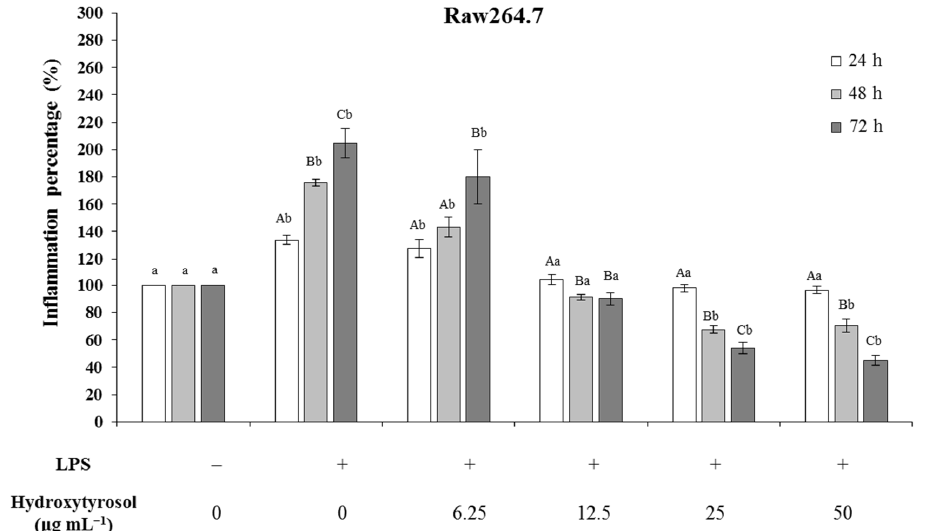
Figure 8. Effect of hydroxytyrosol on the percentages of inflammation measured in terms of nitric oxide (NO) production in Raw264.7 cells when these cells were previously stimulated with LPS (0.1 µg·mL 1 ) and cultured with different concentrations of hydroxytyrosol (0–50 µg·mL 1 ) at 24, 48 and 72 h. The percentage of inflammation of the negative control is represented as 100%. The test was performed in triplicate ( n = 3) for each experimental condition. Capital letters indicate statistically significant differences ( p < 0.05) in the same experimental condition (e.g., LPS (+) & HT (6.65 µg·mL 1 )) between the different times studied (24, 48 and 72 h). Lowercase letters indicate significant differences ( p < 0.05) between the different experimental conditions for a specific time (e.g., 24 h). LPS, Lipopolysaccharide.